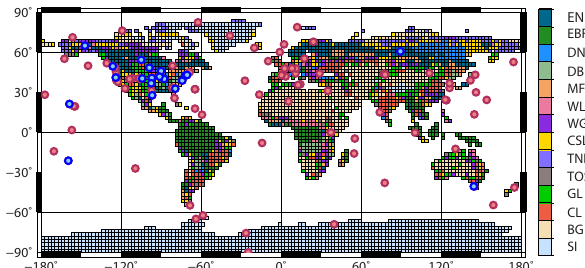
Figure 1. Distributions of the dominant biomes in each grid and the locations of atmospheric CO 2 observation sites. ENF: ever- green needle-leaf forest; EBF: evergreen broad-leaf forest; DNF: deciduous needle-leaf forest; DBF: deciduous broad-leaf forest; MF: mixed forest; WL: woodland; WGL: wooded grassland; CSL: closed shrubland; TND: tundra; TOS: temperate open shrubland; GL: grassland; CL: cropland; BG: bare ground; SI: snow and ice. The blue circles are partial-column CO 2 concentrations and the red circles are surface CO 2